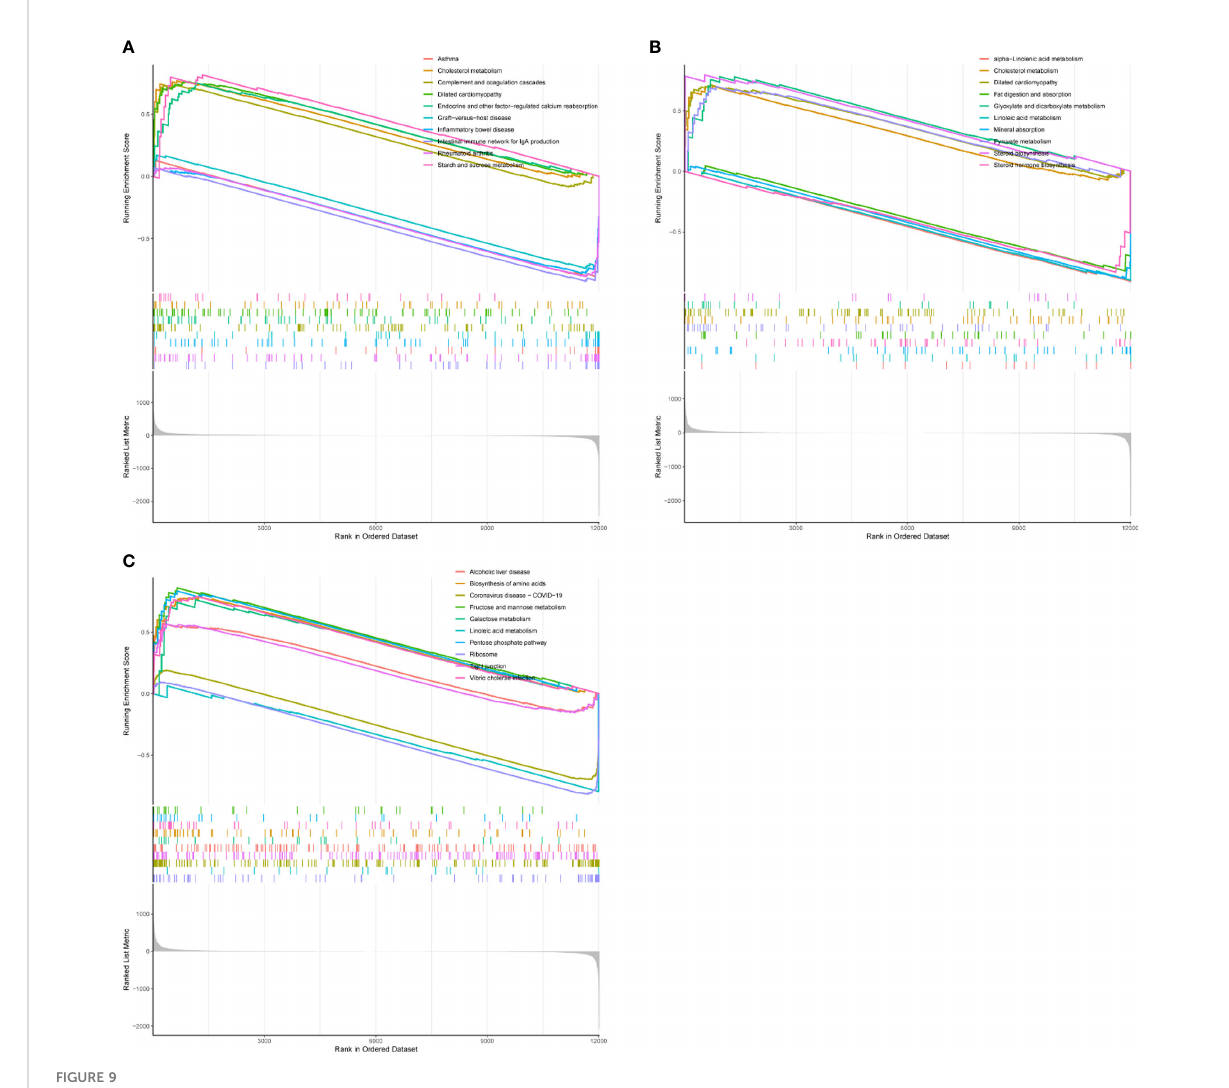
FIGURE 9 GSEA analysis of hub gene. (A) CD8A. (B) GZMB. (C)